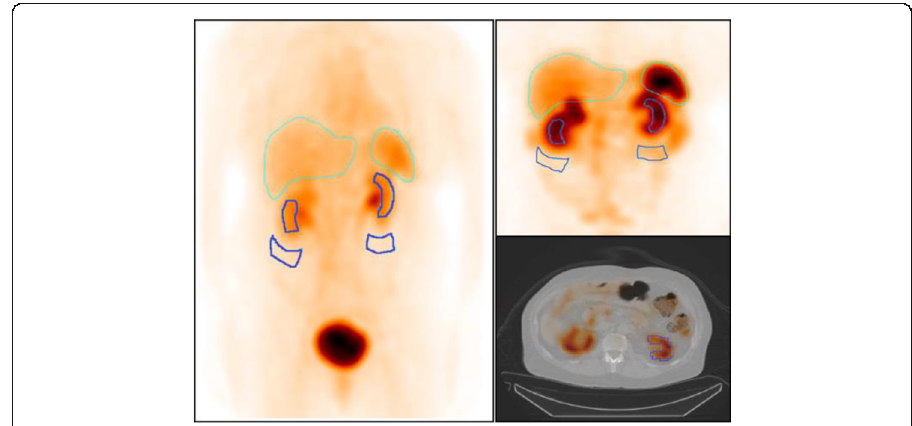
Fig. 2 Examples of quantified planar images acquired 1 and 24 h p.i., with ROIs over kidneys and background (dark blue lines), as well as the SPECT/CT acquired 24 h p.i. with a VOI over the left